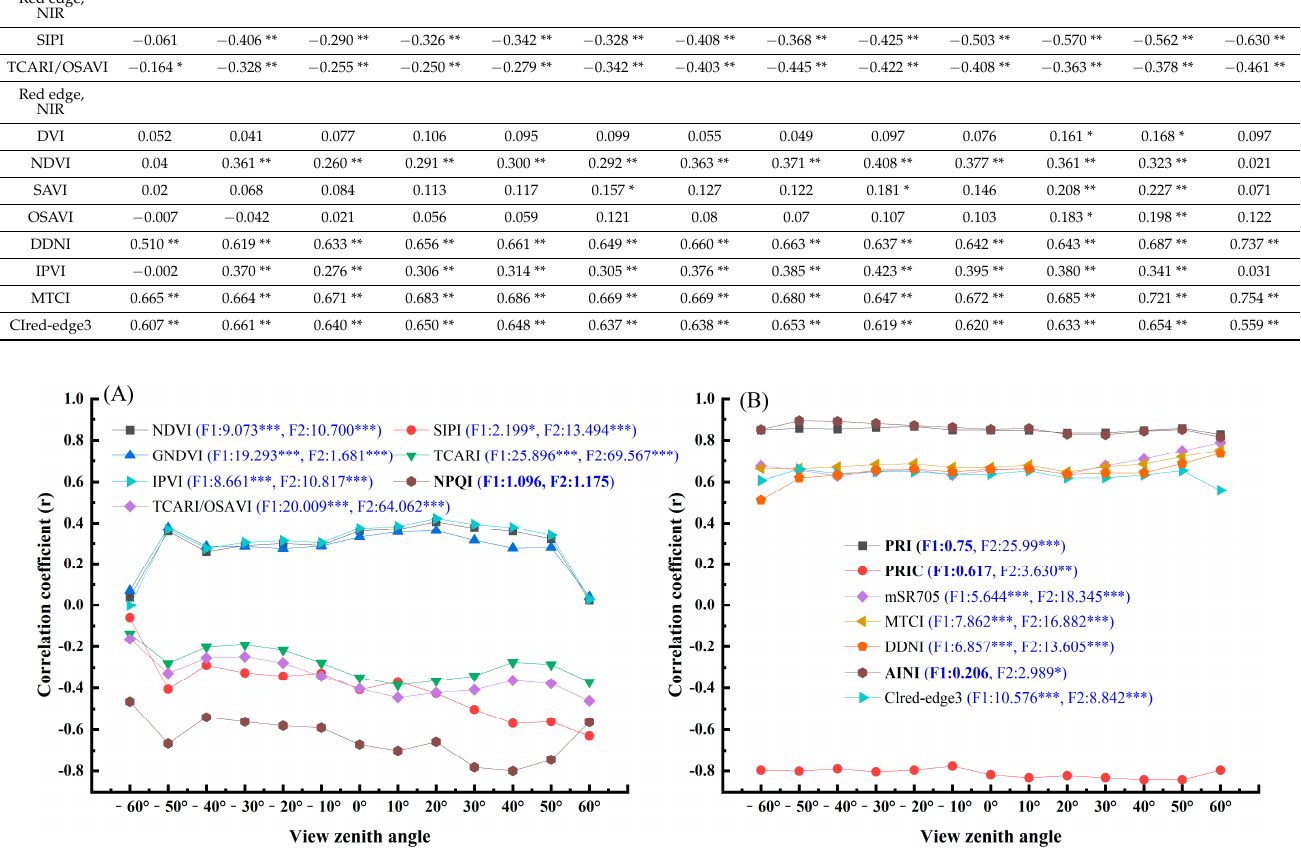
Figure 6. Correlation between spectral indices and ANC under different VZAs. ( A ) VZA sensitivity index, ( B ) VZA insensitivity index. In the brackets of the legend, F1 is the F value of variance analysis in the backscattering direction ( − 60° to 0°), F2 is the F value in the forward scattering direction (0° to 60°), * p < 0.05; ** p < 0.01; *** p < 0.001 .